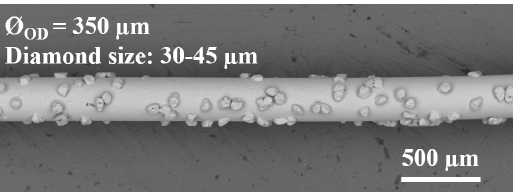
Figure 3. SEM of the Ni-electroplated diamond